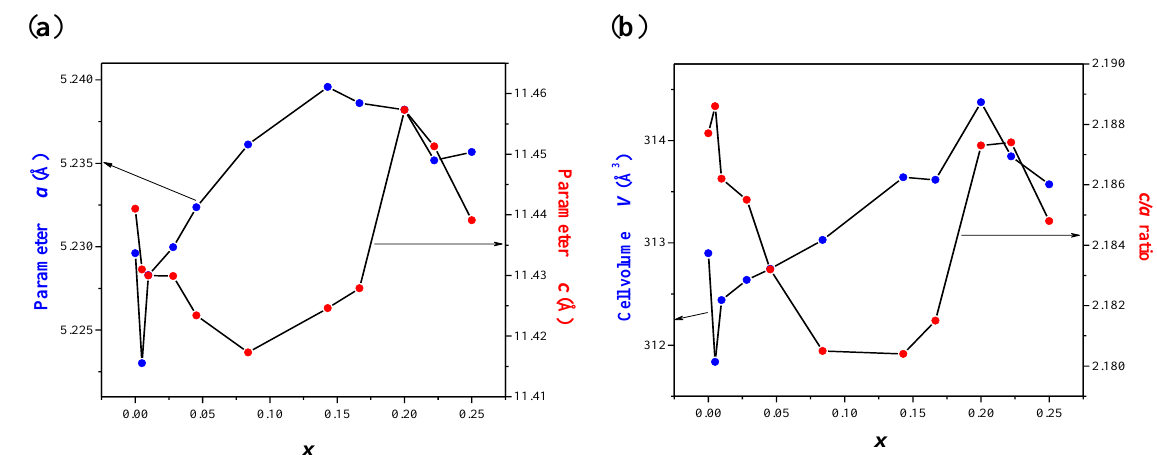
Figure 2. XRD patterns of CaMoO 4 and CaMnGdMoWO samples when 0 < x ≤ 0.2500 and y = 0.0020 ( a , b ) — solid-state reaction method; ( e , f ) — combustion route; when 0 < y ≤ 0.0667 and x = 0.1667 ( c , d ) — solid- state reaction method.